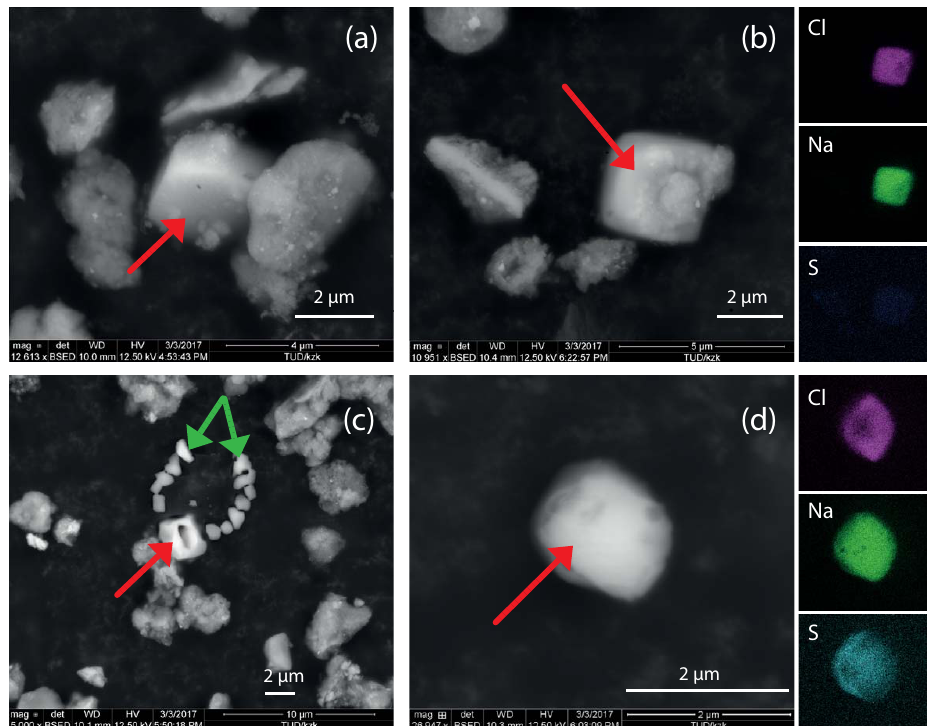
Figure 2. Images of dry atmospheric sea salt particles (red arrows) surrounded by Saharan dust particles, collected during the summer transport regime (summer 2013), whereas the later-presented profile measurements were perfomed in the absence of dust layers in February 2014. The particles were sampled aboard the Falcon research aircraft (Weinzierl et al., 2017) at different heights over Barbados on (a) 21 June, (b) 10 July, (c) 26 June and (d) 30 June 2013 during SALTRACE-1. Sampling altitude and conditions are (a) 2560ma.s.l., 15 ◦ C, 29% RH; (b) 3550ma.s.l., 8 ◦ C, 28% RH; (c) 3570ma.s.l., 7 ◦ C, 39% RH; (d) 3230ma.s.l., 8 ◦ C, 34% RH. For the sea salt particles in (b) and (d) the XRF images are included showing that chloride (Cl) and sodium (Na) are the main components. The sulfate (S) component is negligible for particle (b) but significant for particle (d) , which exhibits a more spherical shape. Panel (c) shows an outline of a former droplet (green arrows), indicating a still (partial) deliquesced state during collection. The white bar in the bottom right corner indicates